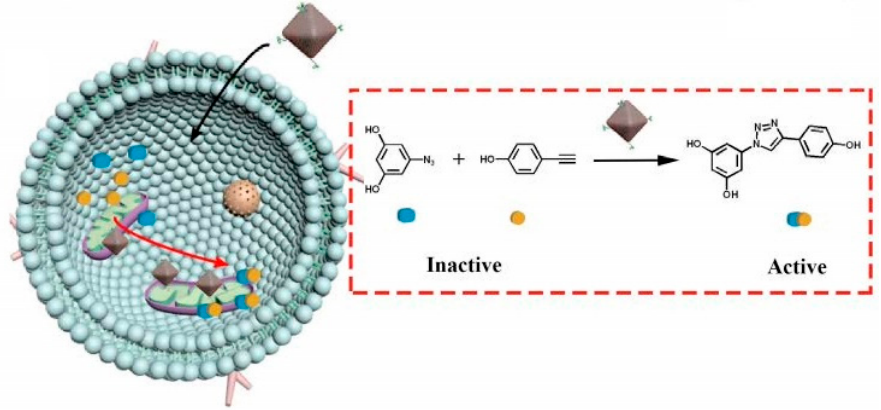
Figure 22. Intracellular bioorthogonal reaction for in situ drug synthesis under mitochondria cata- lyzed by MOF-Cu-TPP. Reproduced from [123] with permission from Wiley, copyright year: 2019.